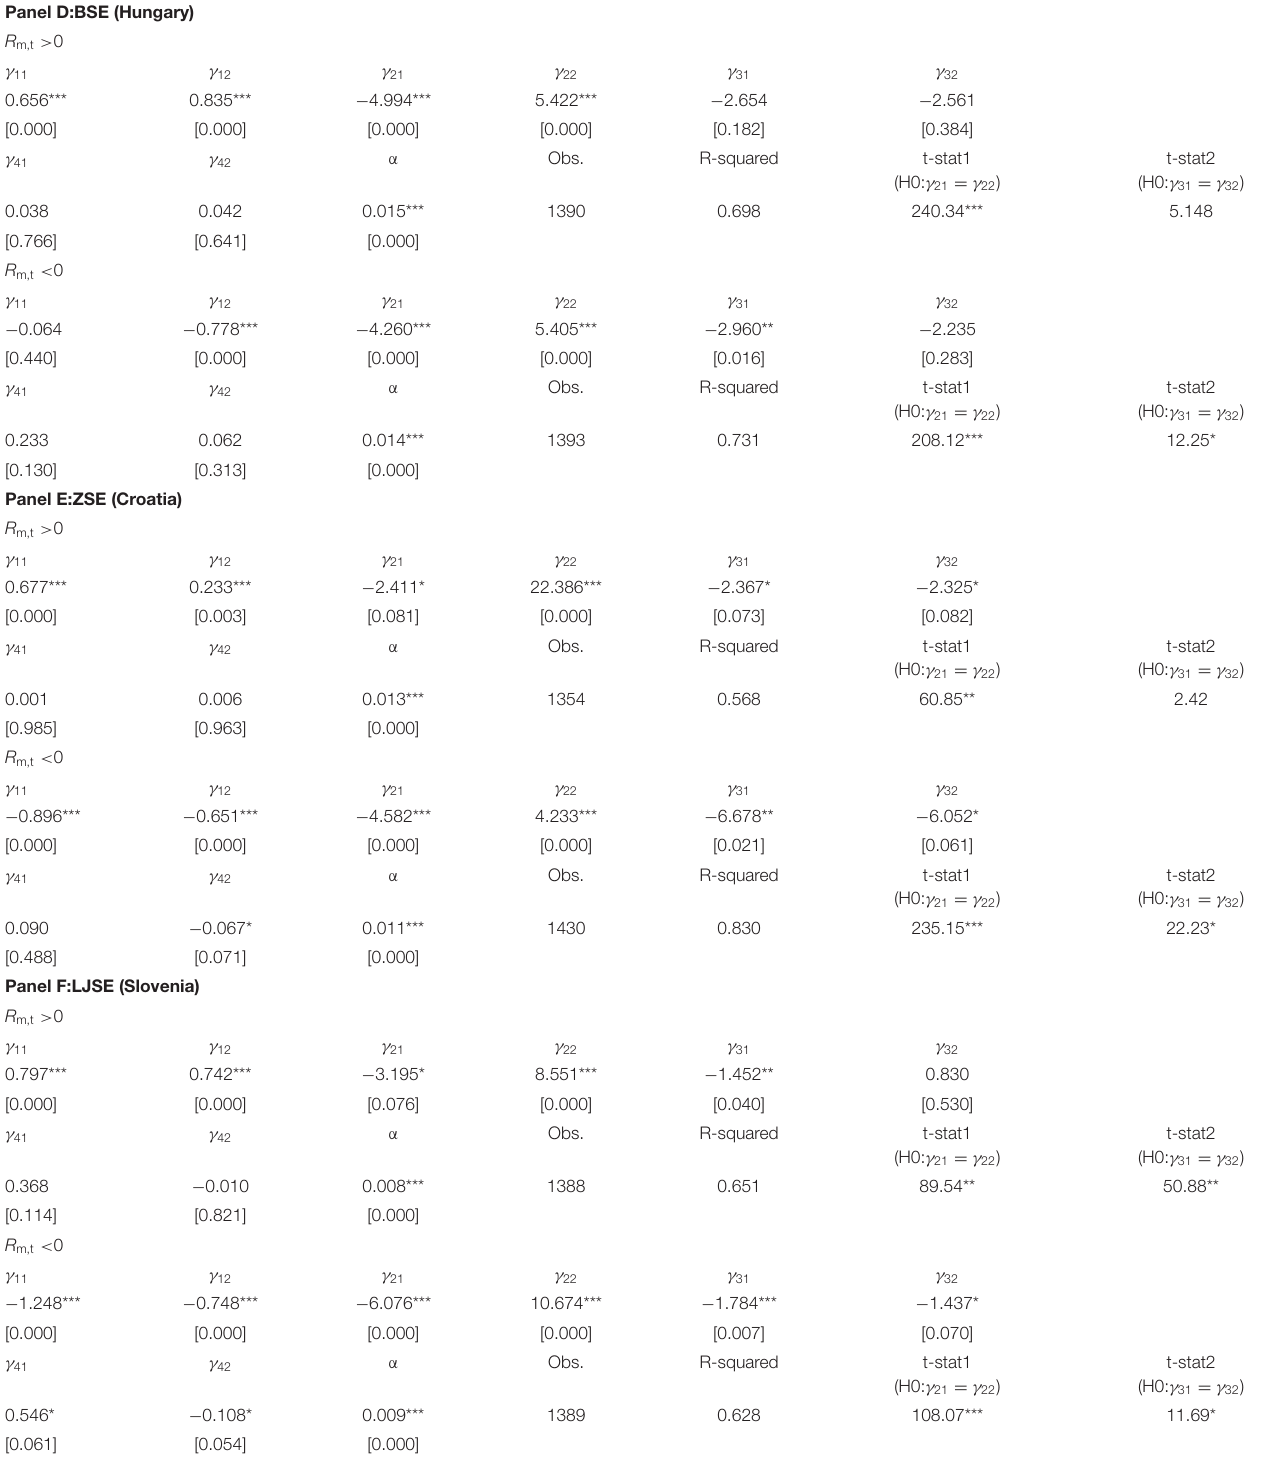
The t-stat1 (H0: γ 21 = γ 22 ) denotes the t-statistic examination for the difference between herding before COVID-19 and herding following COVID-19. The t-stat2 (H0: γ 31 = γ 32 ) denotes the t-statistic examination for the difference between herding caused by the global market returns before COVID-19 and that following COVID-19. p-values in brackets. * p < 0.1, ** p < 0.05, *** p <